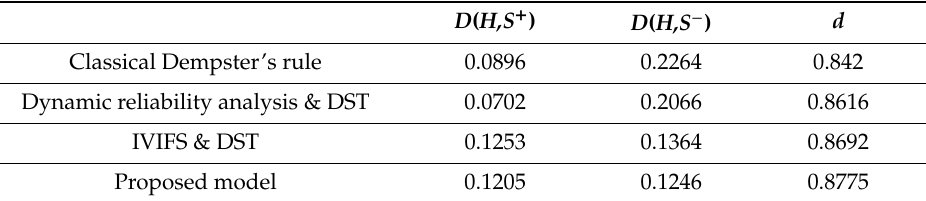
Table 6. The nearness degree of di ff erent decision models.